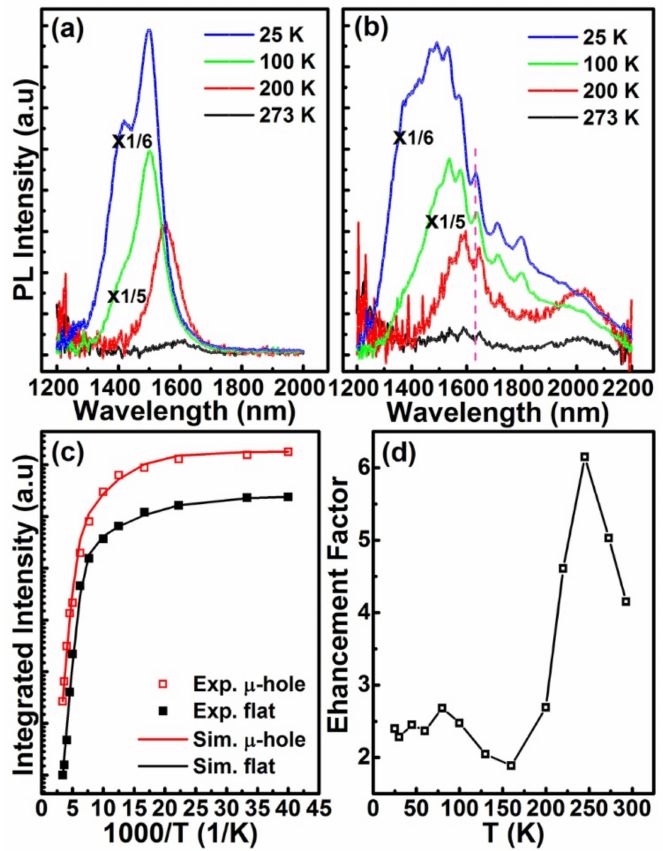
Figure 7. Temperature-dependent PL spectra. PL spectra of graded Ge x Si 1 − x alloys ( a ) on the flat Si(001) substrate, ( b ) on the micro-hole patterned Si(001) substrate, ( c ) the integrated PL intensity vs. temperature, ( d ) the EF vs. temperature. For comparisons, the PL spectra at 25 K and 100 K in ( a , b ) are reduced by multiplying 1/6 and 1/5, as is denoted by ‘x1/6’ and ‘x1/5’, respectively. ‘Exp.’, ‘Sim.’, ‘ µ -hole’ and ‘flat’ in ( c ) denote experiment, simulation, micro-hole patterned substrate and flat substrate, respectively. The dashed pink line is for